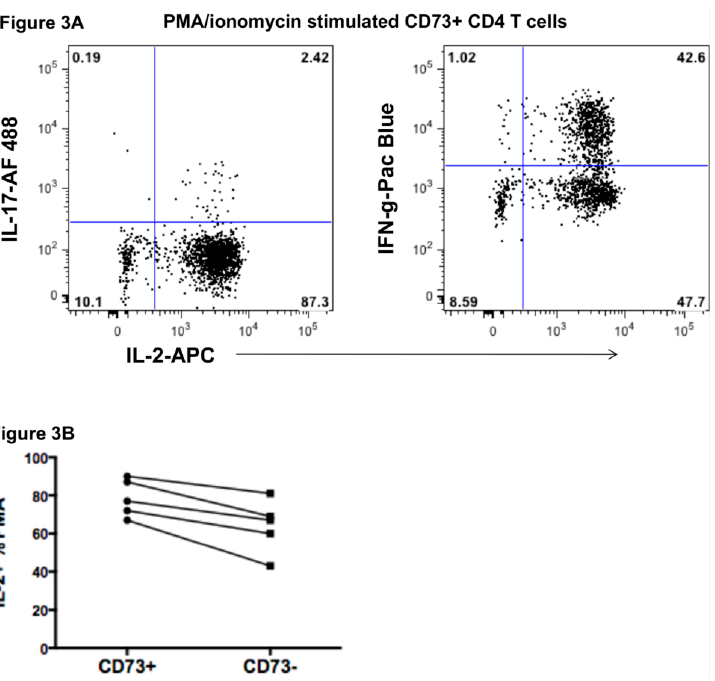
Figure 3. Cytokine production by CD73+ CD45RO+ memory CD4+ T cells. ( A ) Representative flow plots of IL-2, IL-17 and IFN- γ production by CD73+ CD45RO+ memory CD4+ T cells following PMA/ionomycin stimulation in the presence of Brefeldin A. ( B ) Summary data of IL-2 production by CD73+ CD45RO+ memory CD4+ T cells versus CD73-negative CD45RO+ memory CD4+ T cells following PMA/ionomycin stimulation in the presence of brefeldin A.